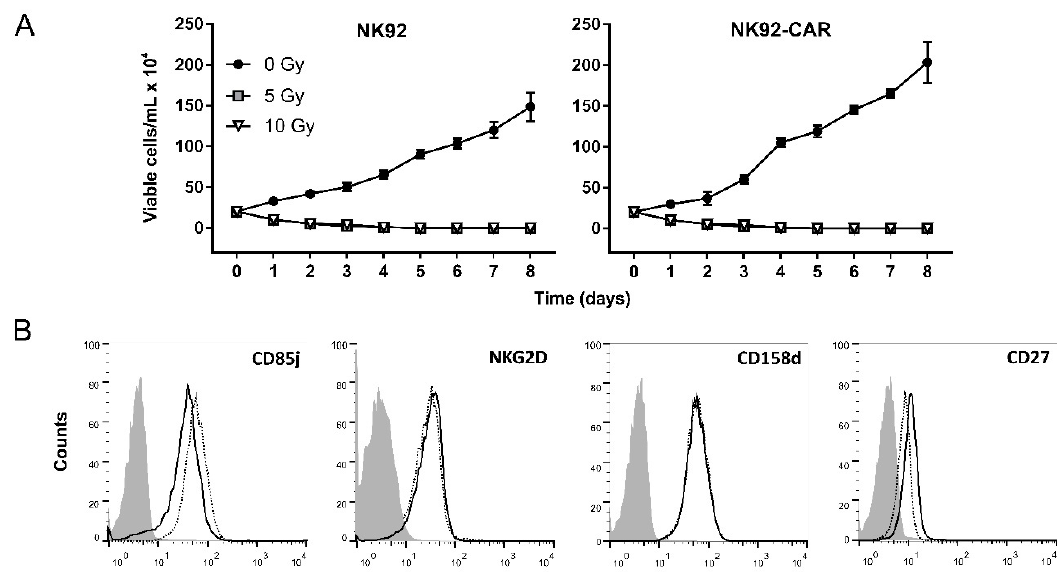
Figure 2. The irradiation of CAR-transduced or parental NK-92 cells fully blocks the proliferation but not impinges on phenotype. ( A ) Viability of NK-92 (left panel) and NK-92/CAR (right panel) cells undergoing or not γ -irradiation at 5 or 10 Gy. Proliferation was analyzed by counting viable cells at the indicated time points using trypan blue exclusion. Results are reported as mean values ± SD of 3 independent experiments. ( B ) Surface expression of different NK (natural killer) cells’ activation/inhibition receptors (CD85j, NKG2D, CD158d, and CD27) after γ -irradiation was analyzed by flow cytometry staining with appropriate antibodies. Solid lines refer to NK-92/CAR cells, while dotted lines represent parental counterparts.